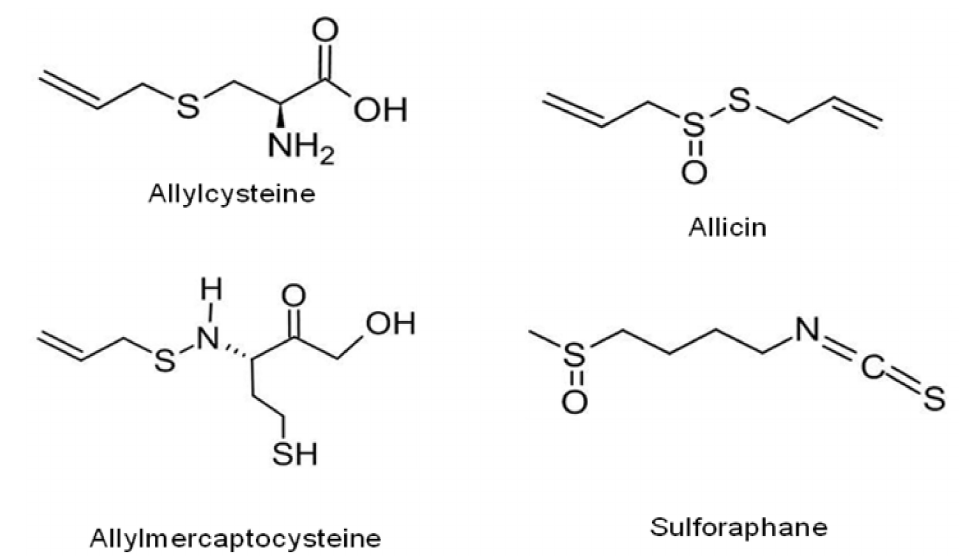
Figure 5. Chemical structures of some lead organosulfur